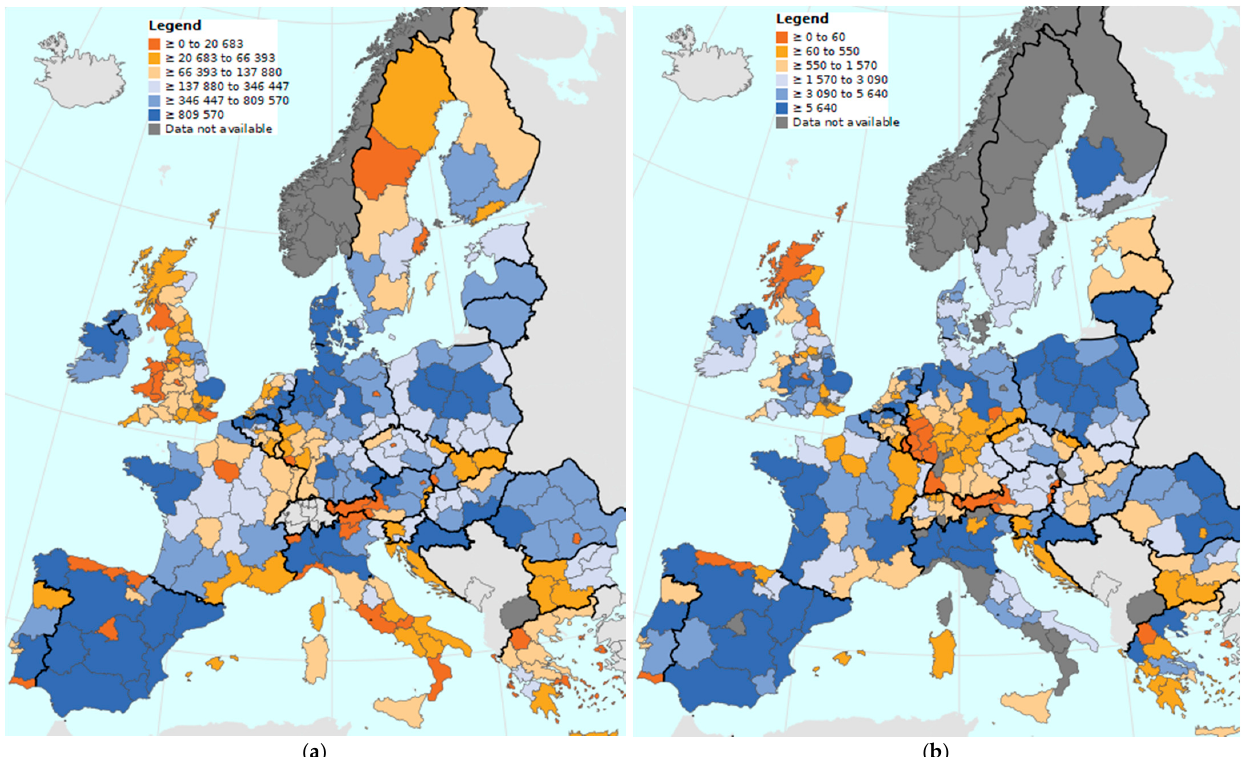
Figure 1. Annual number of heads of live swine ( a ) and 1000s of heads of broiler chicken ( b ) in each of the NUTS2 Regions in 2016 for all farm size categories from 2 to over 100 ha (generated in 2021 by the authors from https://ec.europa.eu/euro- stat/data/database (24 October 2021)).